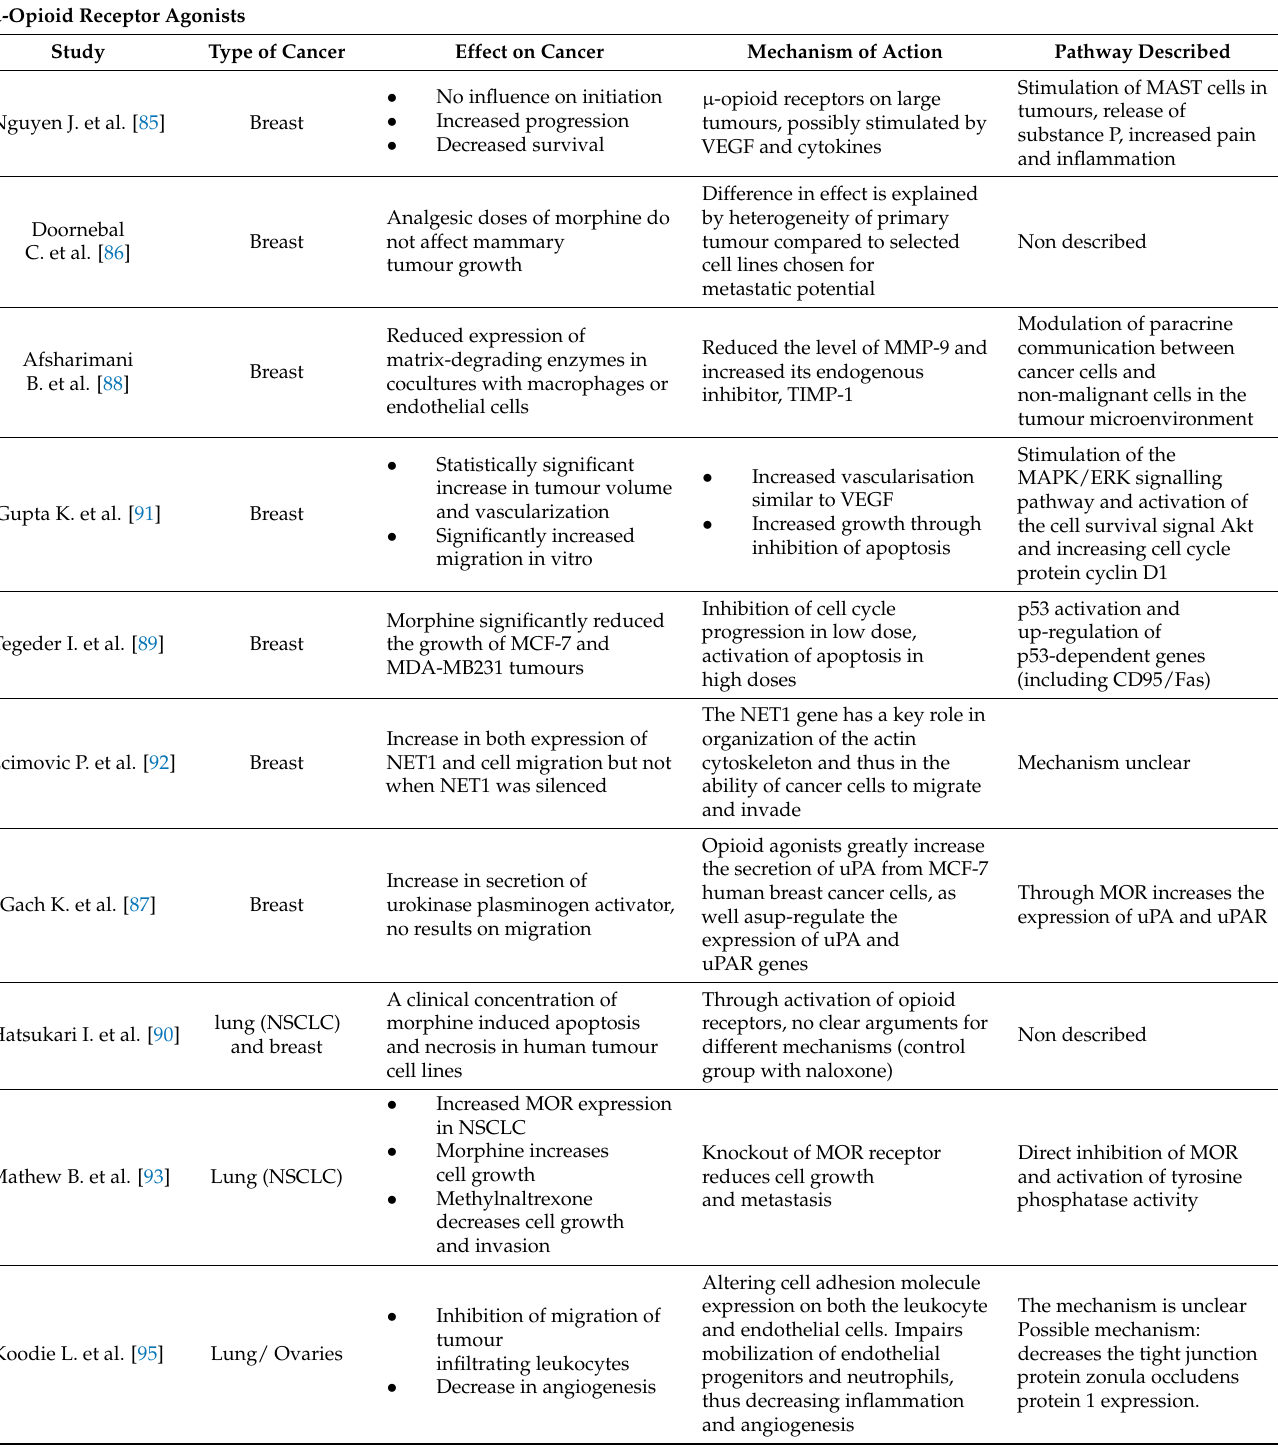
Table 4. Studies describing the direct effects of MOR opioids on cancer cells, the associated mecha- nisms of action and their respective pathways 1